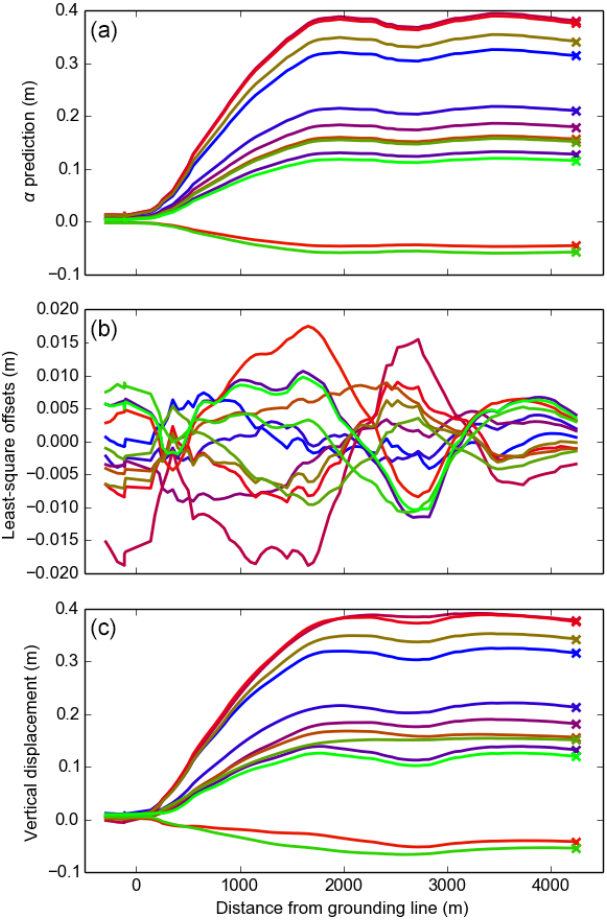
Figure 2. Vertical displacements along a profile through the ground- ing zone of the southern McMurdo Ice Shelf, as (a) measured with nine DInSAR interferograms, (b) predicted from an empirical dis- placement model ( α map) and (c) their difference.